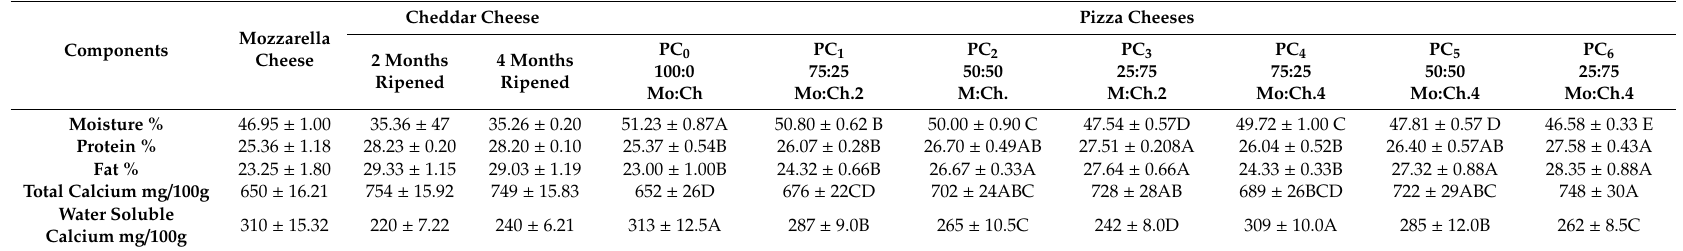
Table 2. Chemical composition of Mozzarella, Cheddar, and Pizza